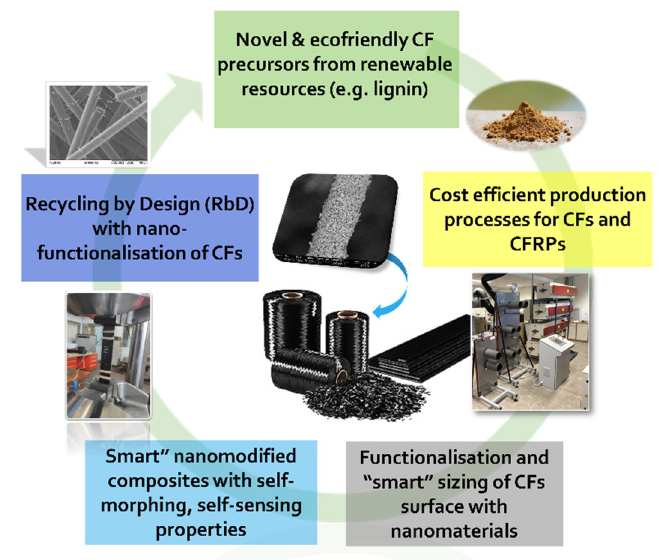
Figure 1. Composite material circular economy; from “green” fibers to nano-enhanced fibrous polymer composites.